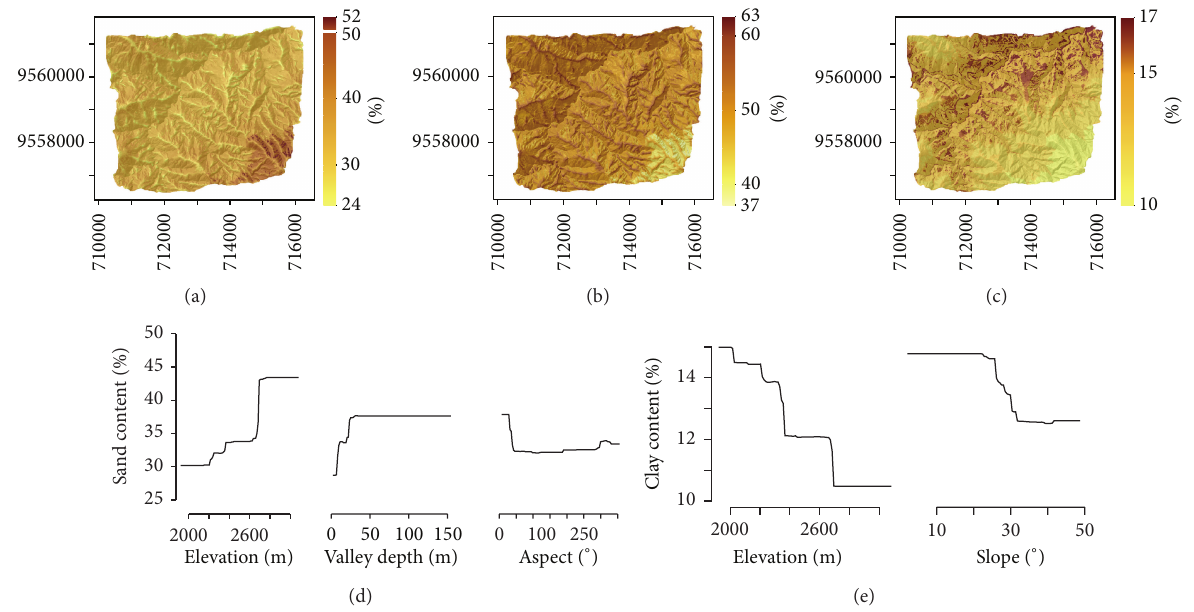
Figure 9: Soil texture maps predicted by gradient boosting with overlaid hillshading from north, (a) sand content, (b) silt content, and (c) clay content and marginal dependence plots displaying the importance of predictors for the sand content (d) and the clay content (e).